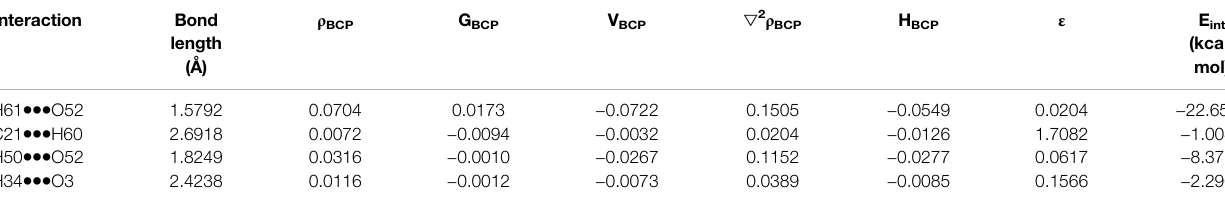
TABLE 2 | Geometrical parameters (bond length) and topological parameters of bonds of interacting atoms in the cocrystal (EZT + L-proline): electron density ( ρ BCP ), Laplacian of electron density ( ▽ 2 ρ BCP ), electron kinetic energy density (G BCP ), electron potential energy density (V BCP ), bond ellipticity ( ε ), total electron energy density (H BCP ) at bond critical point (BCP), and estimated hydrogen bond energy (E int ). Interaction Bond